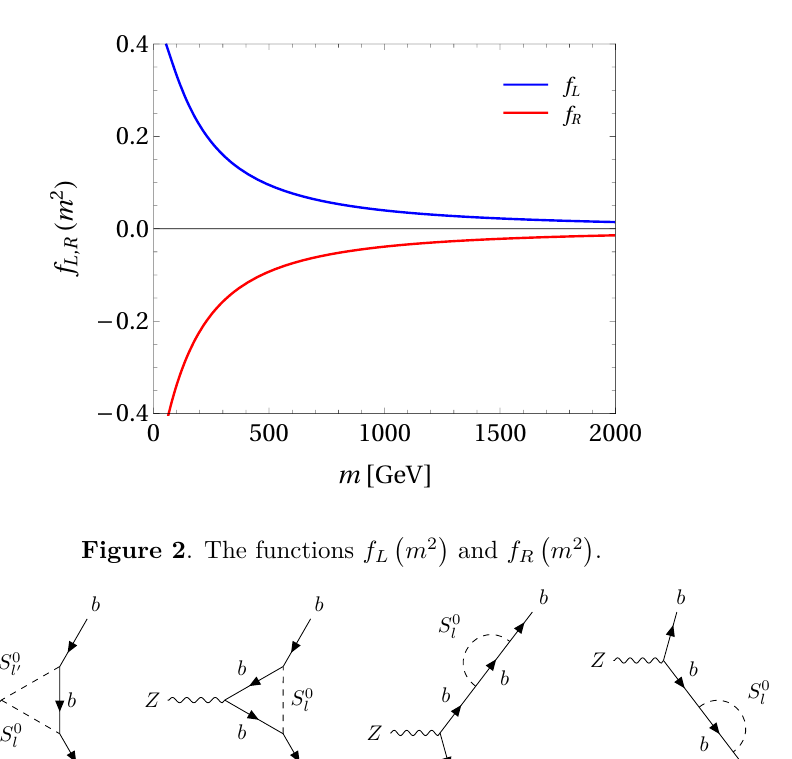
Figure 2 . The functions f L